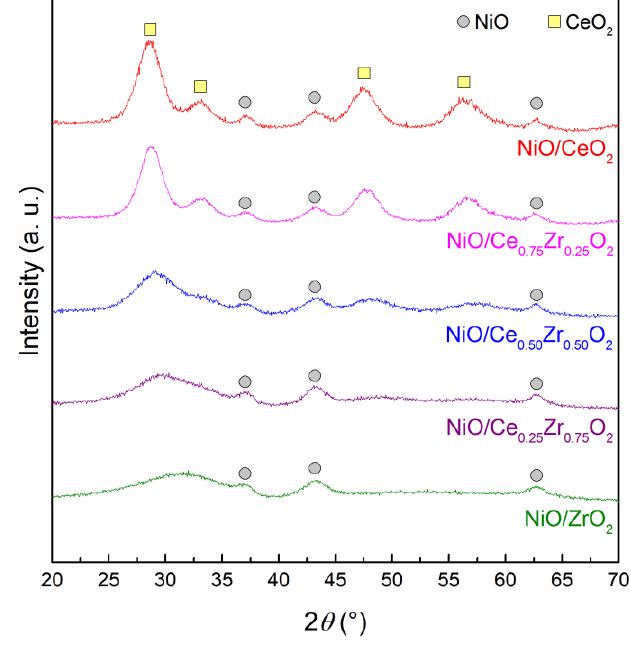
Figure 2. XRD patterns of the fresh NiO/Ce x Zr 1- x O 2 samples.